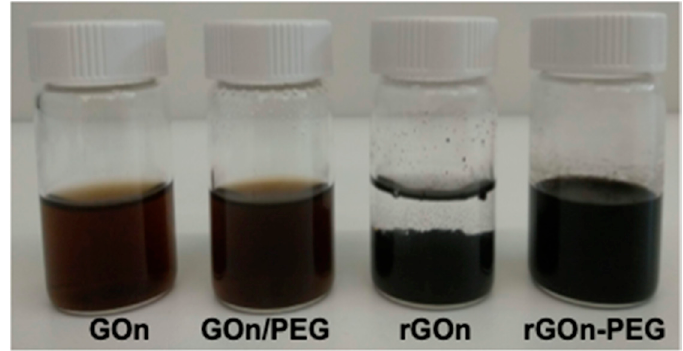
Figure 1. Images of as-prepared GBM dispersions (500 μ g mL − 1 ) in glass vials for stability evaluation. From left to right: GOn dispersion; GOn/PEG (GOn mixed with PEG without thermal treatment); rGOn dispersion (after thermal treatment without PEG functionalization); rGOn-PEG (simultaneously reduced and non-covalently PEGylated).